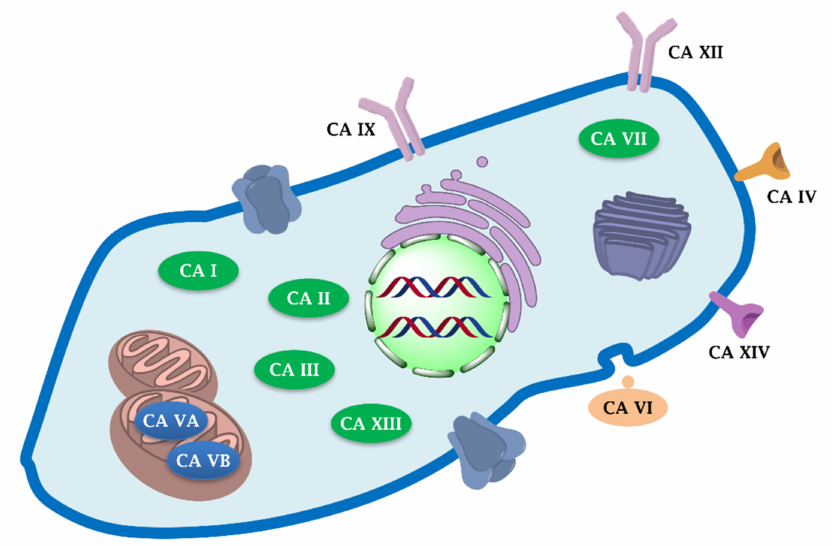
Figure 4. Subcellular localization of hCAs.